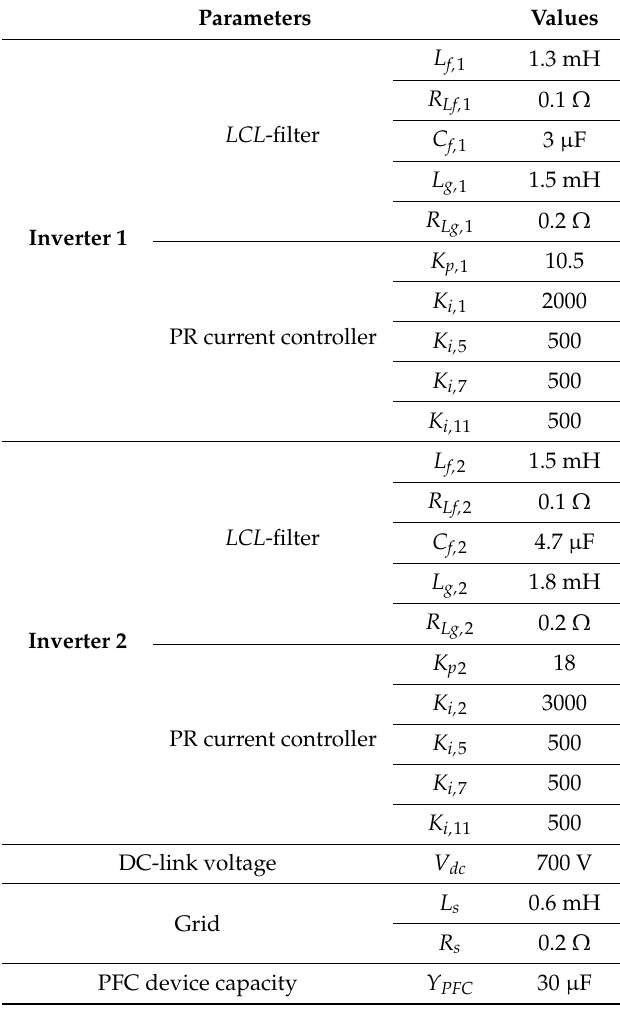
Table 2. Parameters of the inverter system.